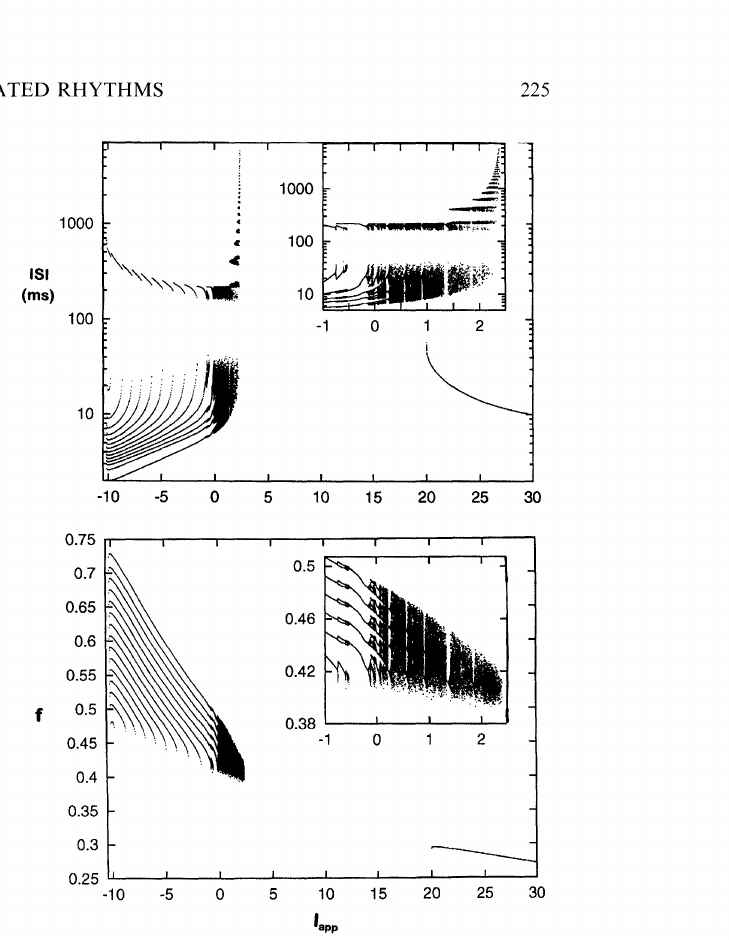
FIGURE 7 Bifurcation diagram for the thalamocortical neuron showing the interspike interval (top) and the inactiv- ation variable of Ic, (bottom) as a function of l,vp. This dia- gram and subsequent two diagrams were constructed by solving the differential equations given in Section 3. ISI and f were obtained whenever the upstroke of a spike crosses the V= -30 mV